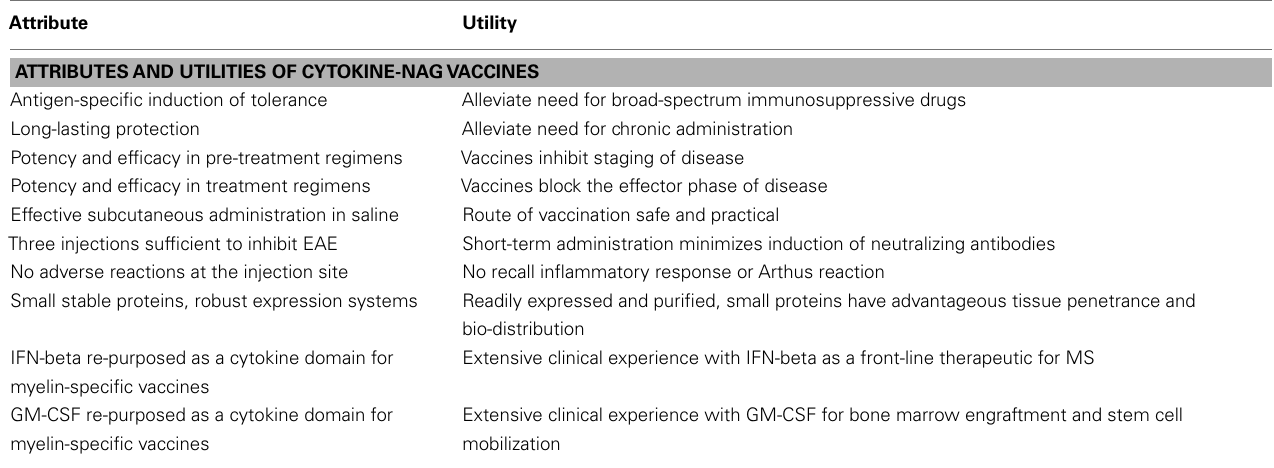
Table 3 | Summary of cytokine-NAg